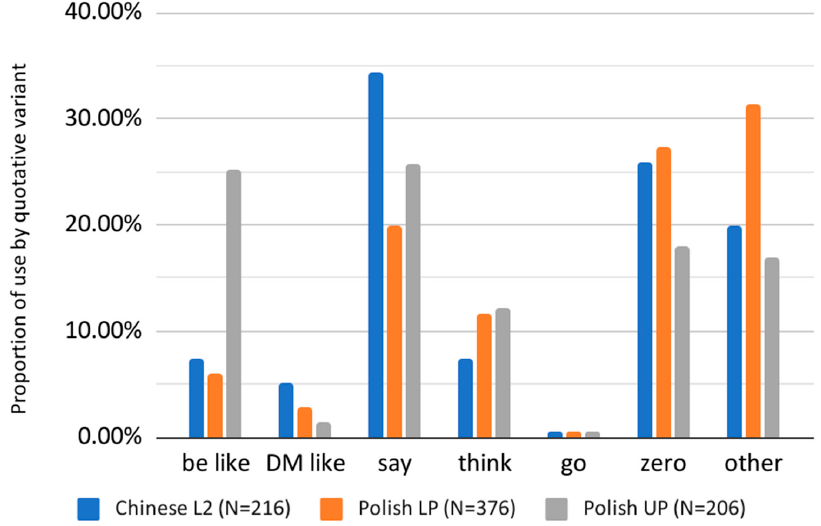
Figure 1. Quotative distribution among L2 groups (Chinese L2, upper and lower proficiency Polish L2 groups).